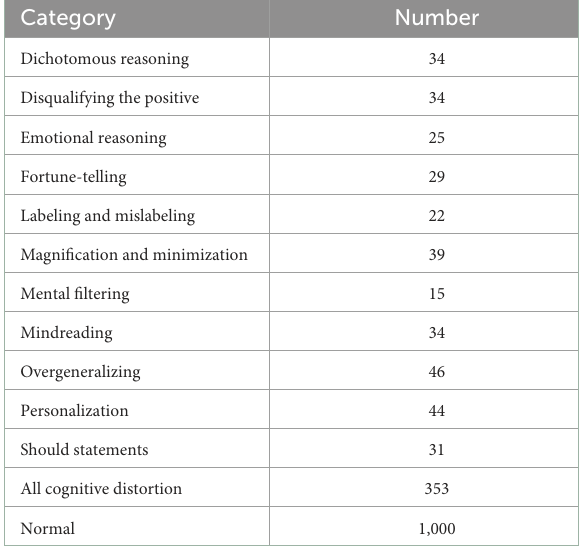
TABLE 2 Eleven common cognitive distortions and their descriptions (14).